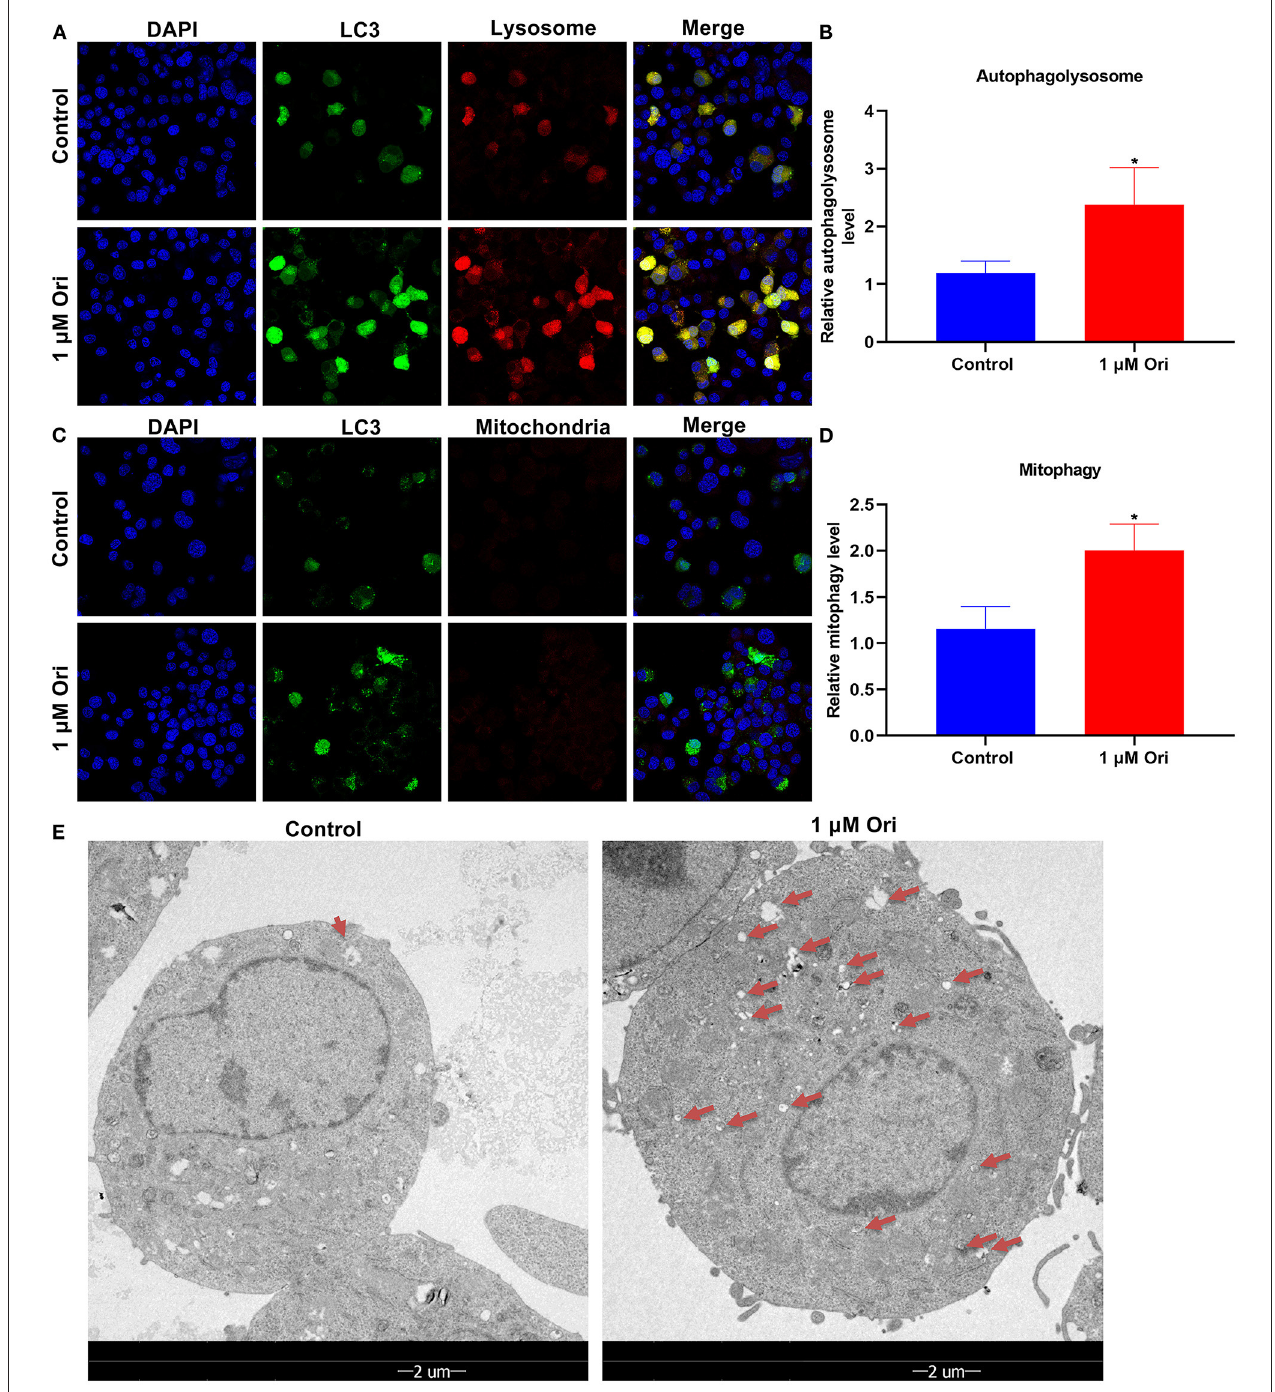
FIGURE 6 | Effect of 1 µ M Ori on autophagy activation in astrocytes. (A) IF staining for astrocytes transfected by mTag-Wasabi-LC3 plasmids. Magnification, 200 × (50 µ m). (B) Autolysosomes were counted in astrocytes treated with 1 µ M Ori. (C) Astrocytes administrated by 1 µ M Ori of which mitochondria were marked through MitoTracker Deep Red. Magnification, 200 × (50 µ m). (D) Mitophagy was quantified in astrocytes treated with 1 µ M Ori. (E) TEM showing the morphology and number of autophagosomes in astrocytes treated with 1 µ M Ori. Red arrows, autophagosomes. Magnification, 1700 × (2 µ m). N = 3 each group. P values were calculated with student’s t test. * P <